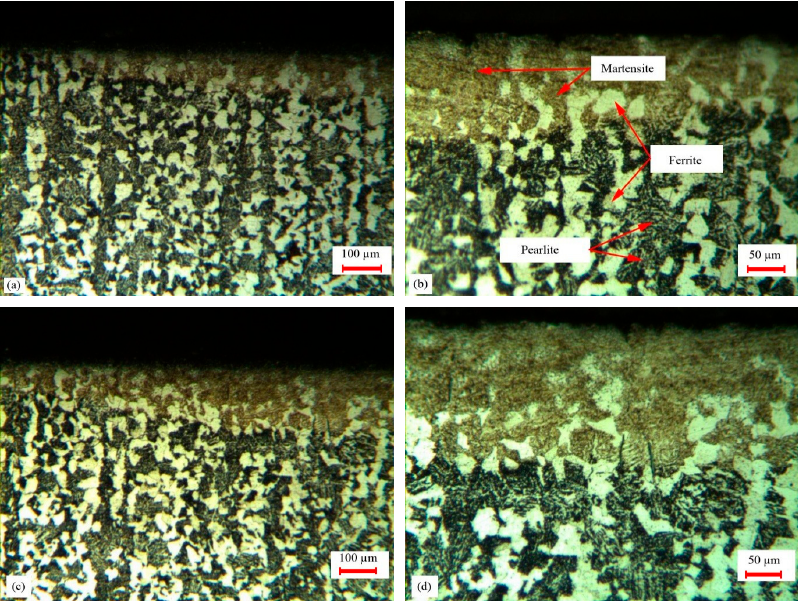
Figure 12. Microstructure of the LH zone of samples #5 and #9. ( a ) 50X of sample #5; ( b ) 100X of sample #5, ( c ) 50X of sample #9; ( d ) 100X of sample #9.